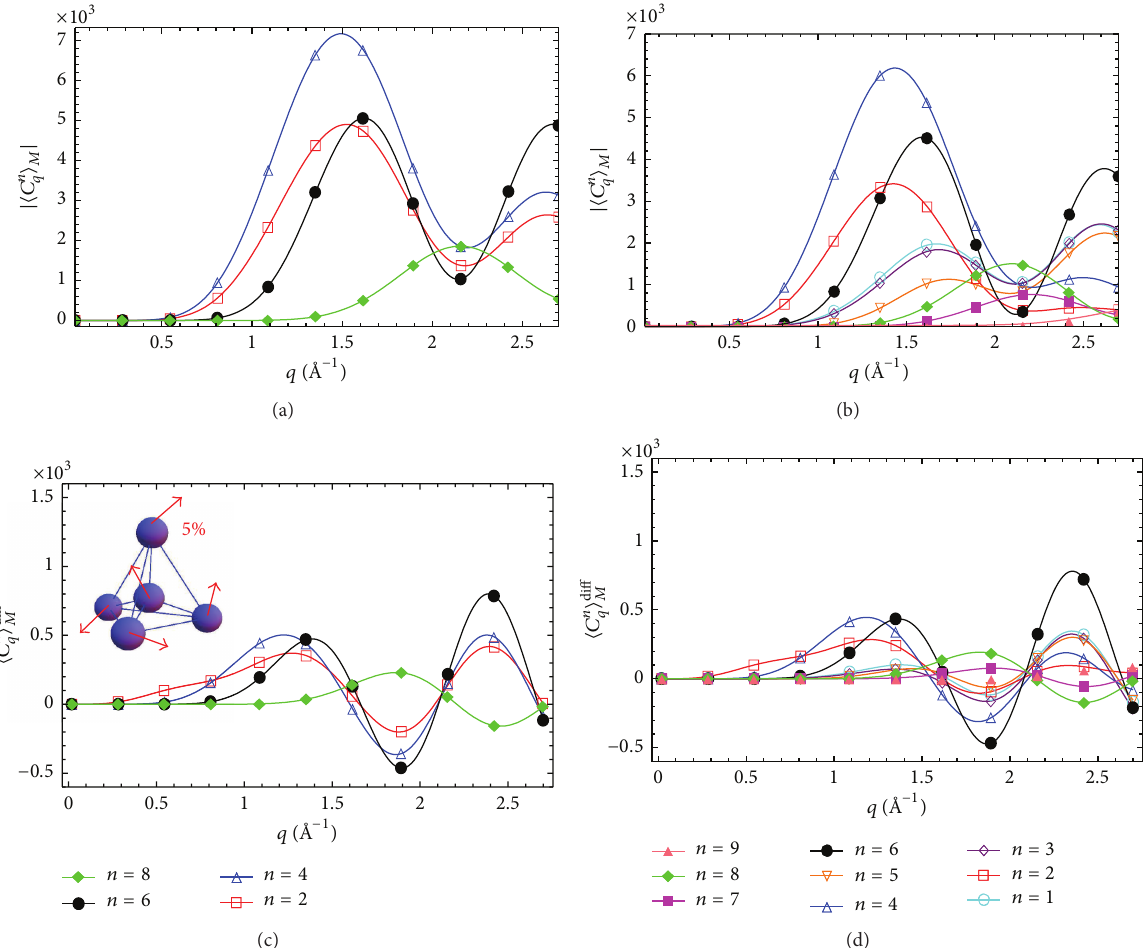
Figure 6: Fourier spectra ⟨𝐶 𝑛 𝑞 ⟩ calculated as a function of 𝑞 for 1 ≤ 𝑛 ≤ 9 , for a flat (a), (c) and curved (b), (d) Ewald sphere. (a), (b) 𝑀 | calculated in dilute limit approximation of scattering (see (13)) from 𝑁 = 10 clusters, averaged over 𝑀 = 10 4 diffraction Amplitudes |⟨𝐶 𝑛 𝑞 ⟩ 𝑀 patterns. (c), (d) Difference spectra ⟨𝐶 𝑛 𝑞 ⟩ diff calculated in the dilute limit approximation for a distorted oxygen pentamer for 𝑁 = 10 , and 𝑀 𝑀 = 10 4 (see text for details). All atoms in each pentamer cluster in the sample were randomly displaced by 5 % of the O-O distance from the positions of a regular pentamer. The scattered intensities used for calculation of the spectra shown in Figures 6 and 7 are expressed in the units of classical electron radius squared, and the spectra were normalized by the number of particles 𝑁 in the